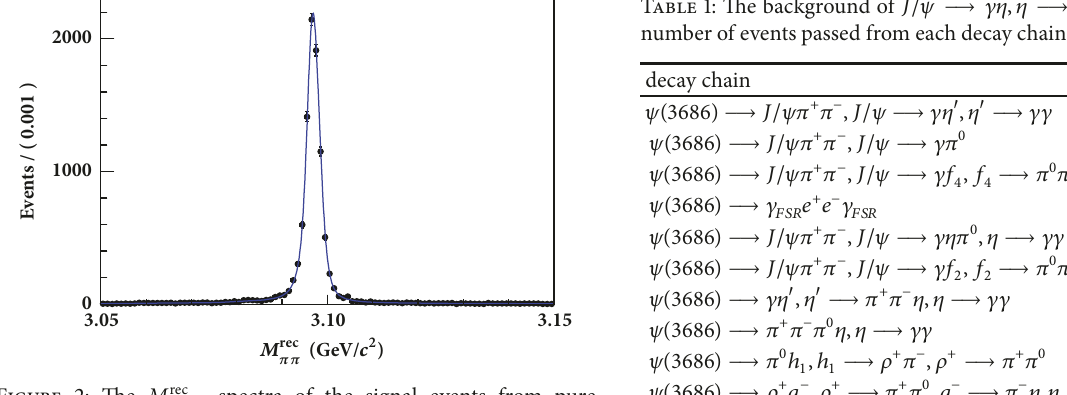
Figure 2: The 𝑀 rec 𝜋 + 𝜋 − spectra of the signal events from pure 𝜓(3686) 󳨀→ 𝐽/𝜓𝜋 + 𝜋 − , 𝐽/𝜓 󳨀→ 𝜇 + 𝜇 − sample (the dots with error bars) and the signal shape (the solid blue line).